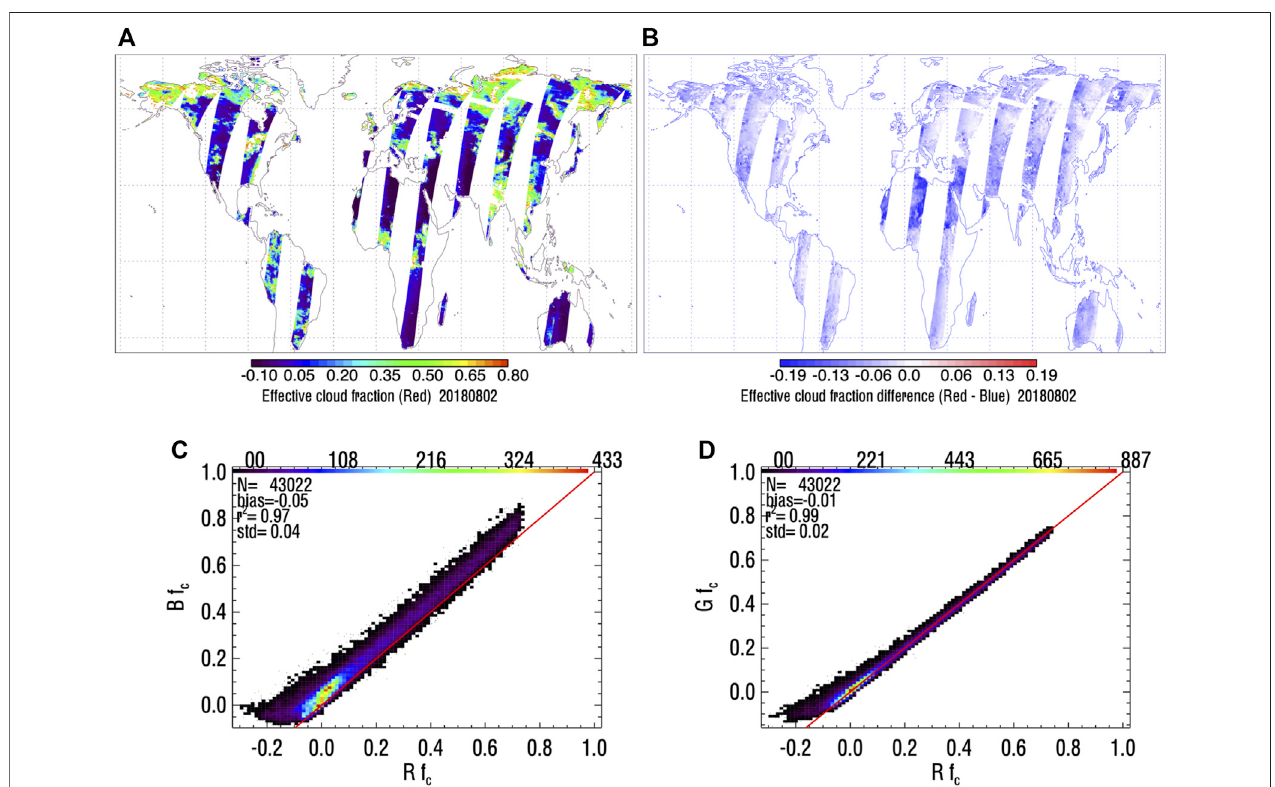
FIGURE10| f c computedatdifferentwavelengthsfromAugust2,2018GOME-2data: (A) f c computedattheredbandwavelength; (B) mapofdifferencebetween computed f c atred andbluewavelengths; (C) density plotof f c at redandblue wavelengths; (D) densityplotof f c atredand greenwavelengths.Theredlineinpanels (C) and (D) is the 1:1